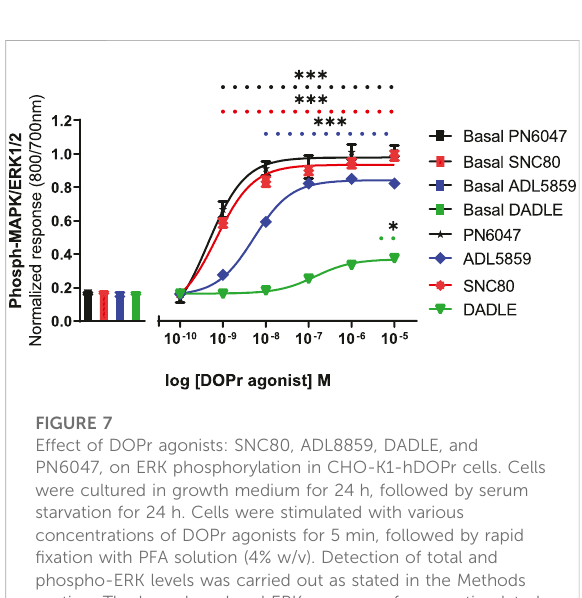
FIGURE 6 Effect of apyrase on phospho-ERK response (basal and SN80-stimulated ERK phosphorylation) in the absence or presence of 2 units/ml of apyrase incubated for 30 min. Individual ERK phosphorylation values were normalized to the corresponding total-ERK values. The data shown are the mean ± SEM values from four independent experiments performed in triplicate. The bars show basal ERK responses from unstimulated cells. No statistical difference was observed between the two responses (with and/or without apyrase) (ns p > 0.05; unpaired two-tailed t test).